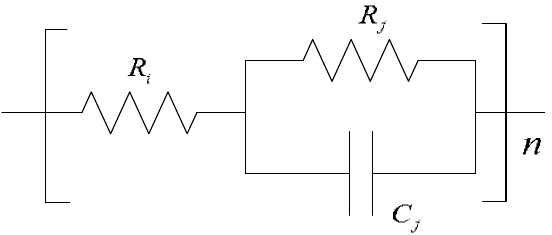
Figure 3. The equivalent circuit model of cement-based materials.